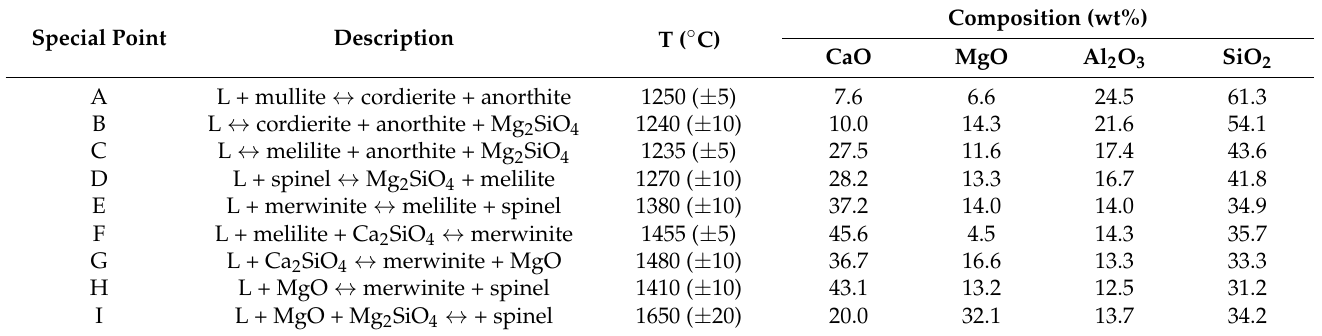
Figure 4. Comparison of the present results with the literature data [10,12]. Table 1. Estimated compositions and temperatures of the special points in the CaO-MgO-Al 2 O 3 -SiO 2 system with Al 2 O 3 /SiO 2 weight ratio of 0.4.